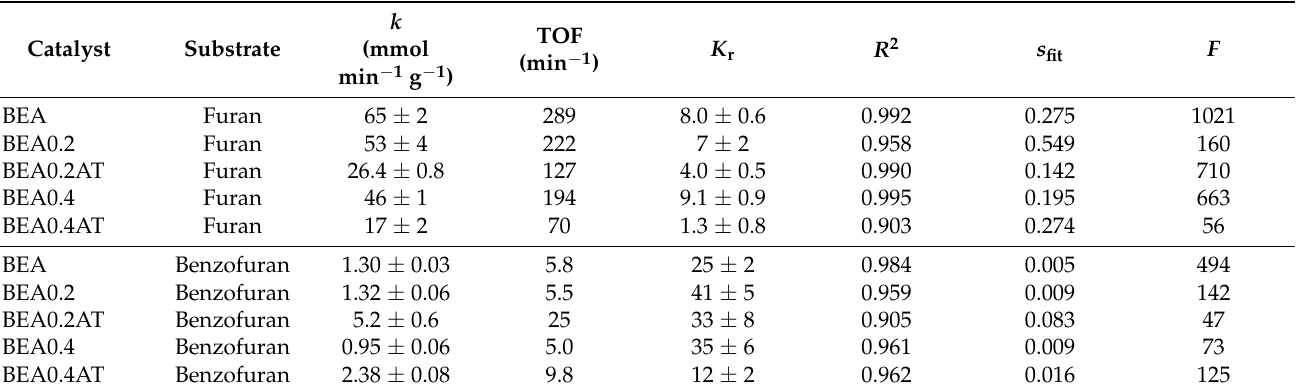
Table 3. Rate constants ( k ), turnover frequencies (TOF), and relative sorption equilibrium constants ( K r ) of Friedel-Crafts acylation reaction of furan and benzofuran with acetic anhydride. Also pre- sented are the fits’ statistical figures of merit: determination coefficient ( R 2 ), regression standard deviation of fit ( s fit ), and Fisher–Snedecor parameter ( F)